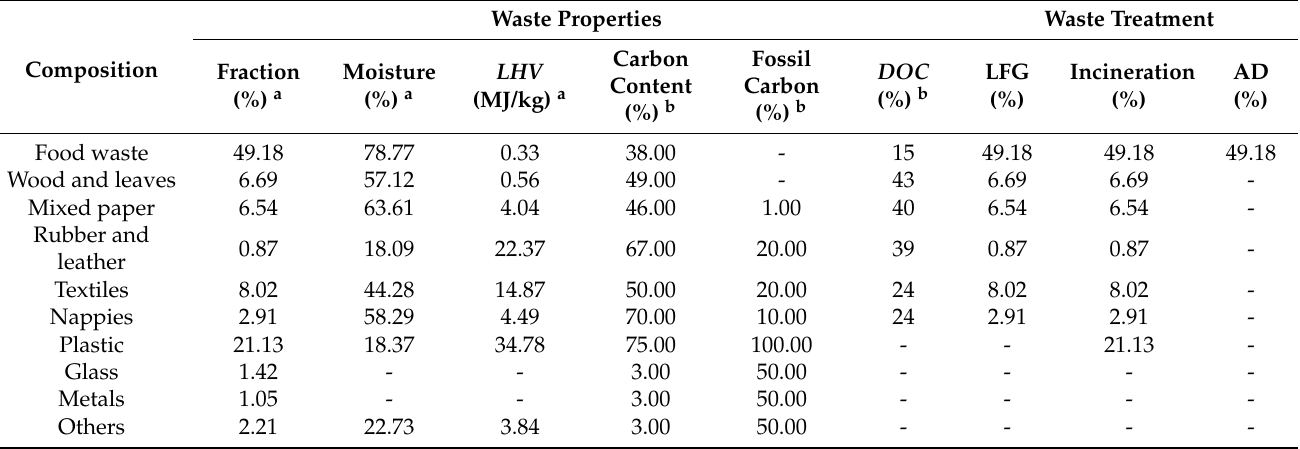
Table 1. MSW characteristics in Phnom